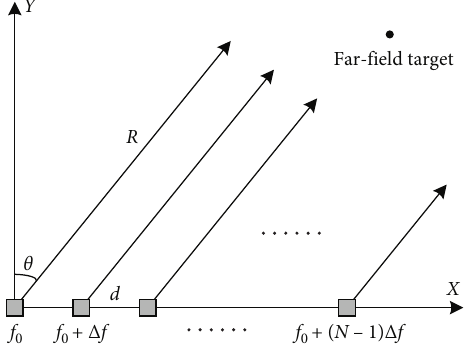
Figure 1: The model of frequency diverse